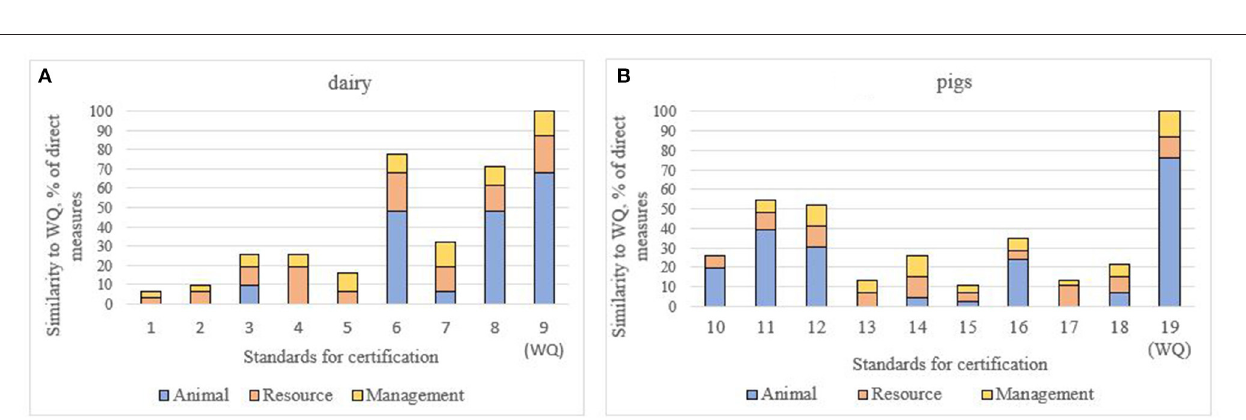
FIGURE 2 | The direct correspondence to WQ ® according to the type (animal-, resource-, management-based) in dairy (A) and pigs (B) standards for certification. The direct correspondence was assigned to measures with the same source of information (animal, their handling, or their environment) as defined in WQ ® . Standards 9 and 19 correspond to one certification scheme that was based fully on WQ ® and represent the distribution of animal-, resource- and management-based measures in WQ ® for dairy cows and pigs. Standards listed in Table 1 were assigned to numbers